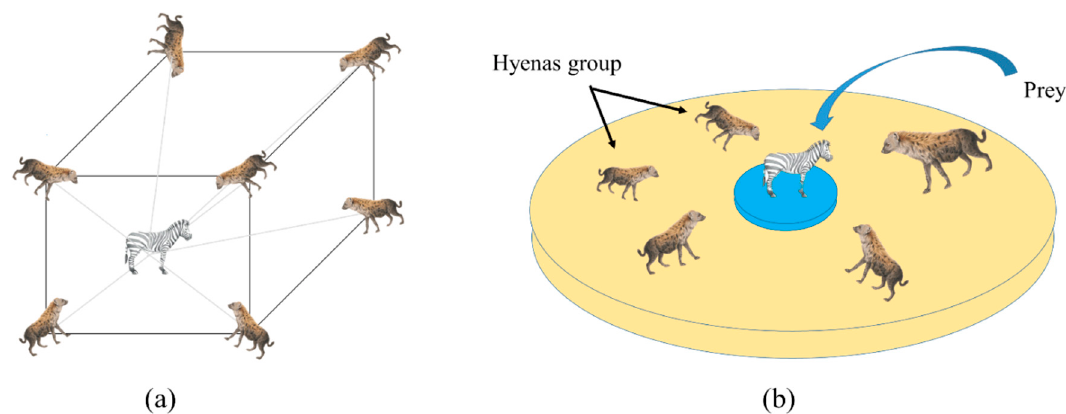
Figure 2. Hunting process carried out in the spotted hyena optimizer (SHO) algorithm: ( a ) position vectors and the possible next locations of the members, and ( b ) attacking the prey.